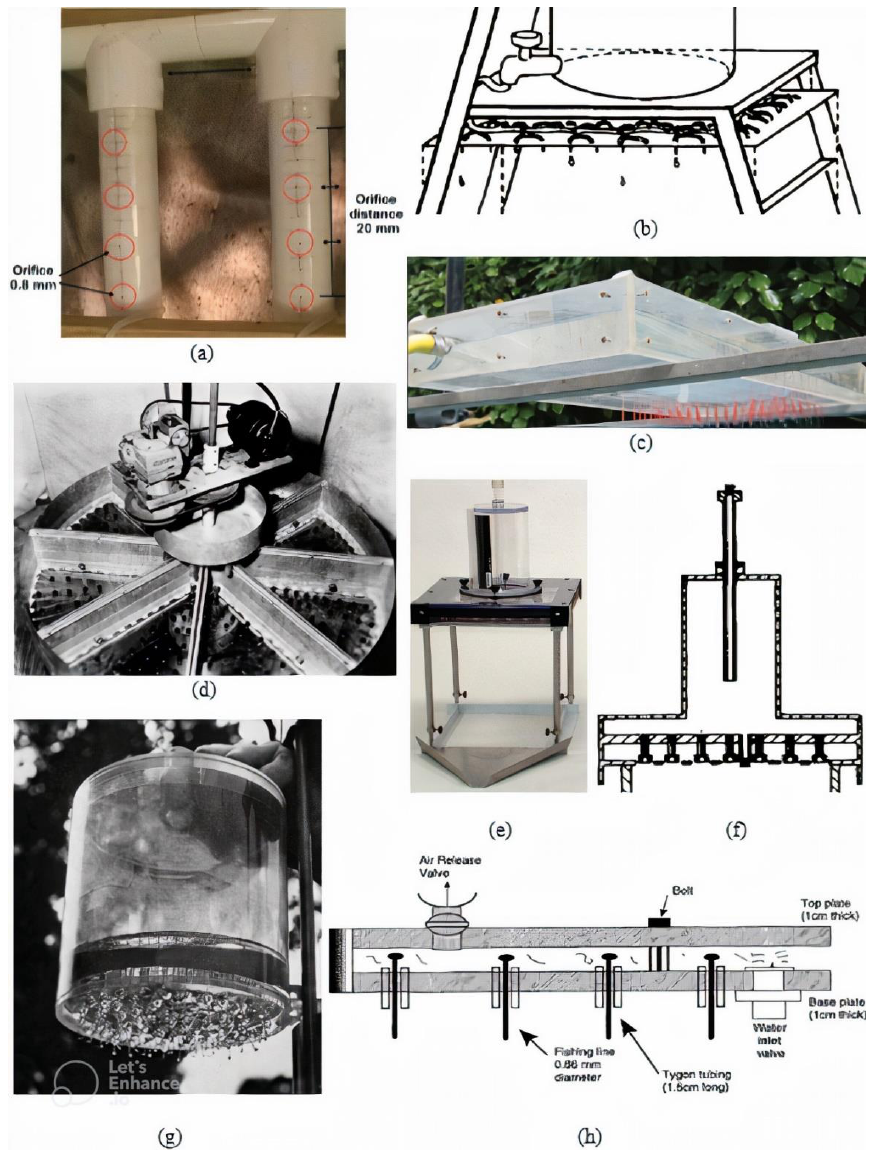
Figure 5. Different water tanks with drippers: ( a ) The water tank with drippers in a form of tubes [53] (Reprinted/adapted with permission from Ref. [Nampulá et al., 2016]); ( b ) Dendritic plastic tubes water tank with drippers [22] (Reprinted/adapted with permission from Ref. [Imeson, 1977]); ( c ) Closed rectangular box water tank with drippers [10] (Reprinted/adapted with permission from Ref. [Corona et al., 2013]); ( d ) Open cylindric box water tank with drippers [63] (Reprinted/adapted with permission from Ref. [Blackburn et al., 1974]); ( e , f ) Complex box water tank with drippers [101,102] (Reprinted/adapted with permission from Ref. [Kamphorst, 1987; Eijkelkamp, 2018 (Eijkelkamp — Laboratory equipment. Available online: https://www.royaleijkelkamp.com/prod- ucts/?gclid=Cj0KCQjw166aBhDEARIsAMEyZh7B0oWCwK61ruEC4Ex0SFSpnAGOWcLClIa915RX HzgnKfzxq8rk6MMaAuh3EALw_wcB (accessed on 7 July 2018))]; ( g ) Closed cylindric box water tank with drippers [39] (Reprinted/adapted with permission from Ref. [Tricker, 1979]); ( h ) Closed rectangular box water tank with drippers with opening for air and water [60] (Reprinted/adapted with permission from Ref. [Andersen, 1999]).